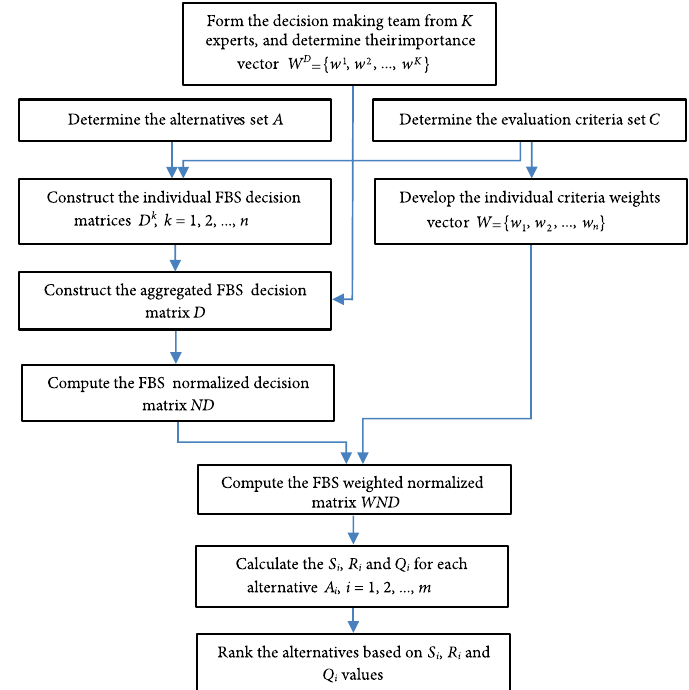
Fig. 1. The flowchart of proposed FBS-VIKOR method for MAGDM